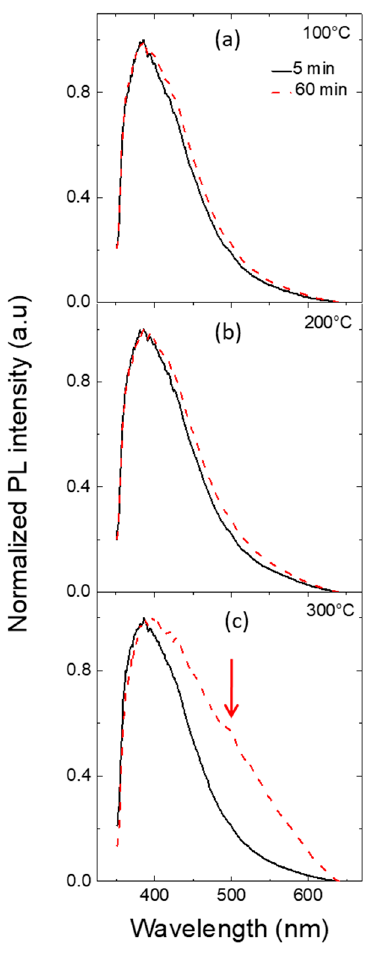
Figure 8. Normalized photoluminescence spectra of ZnO nanowalls grown for 5 (solid black line) and for 60 minutes (dashed red line) after thermal annealing at 100 °C ( a ), 200 °C ( b ), and 300 °C ( c ).